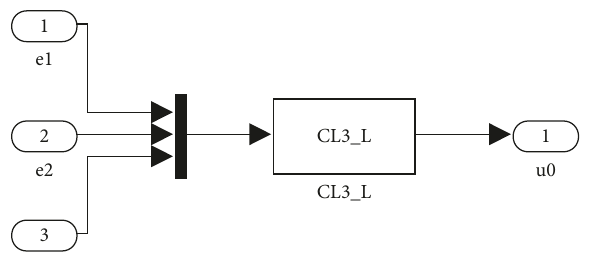
Figure 16: Modular composition of the CL subsystem.